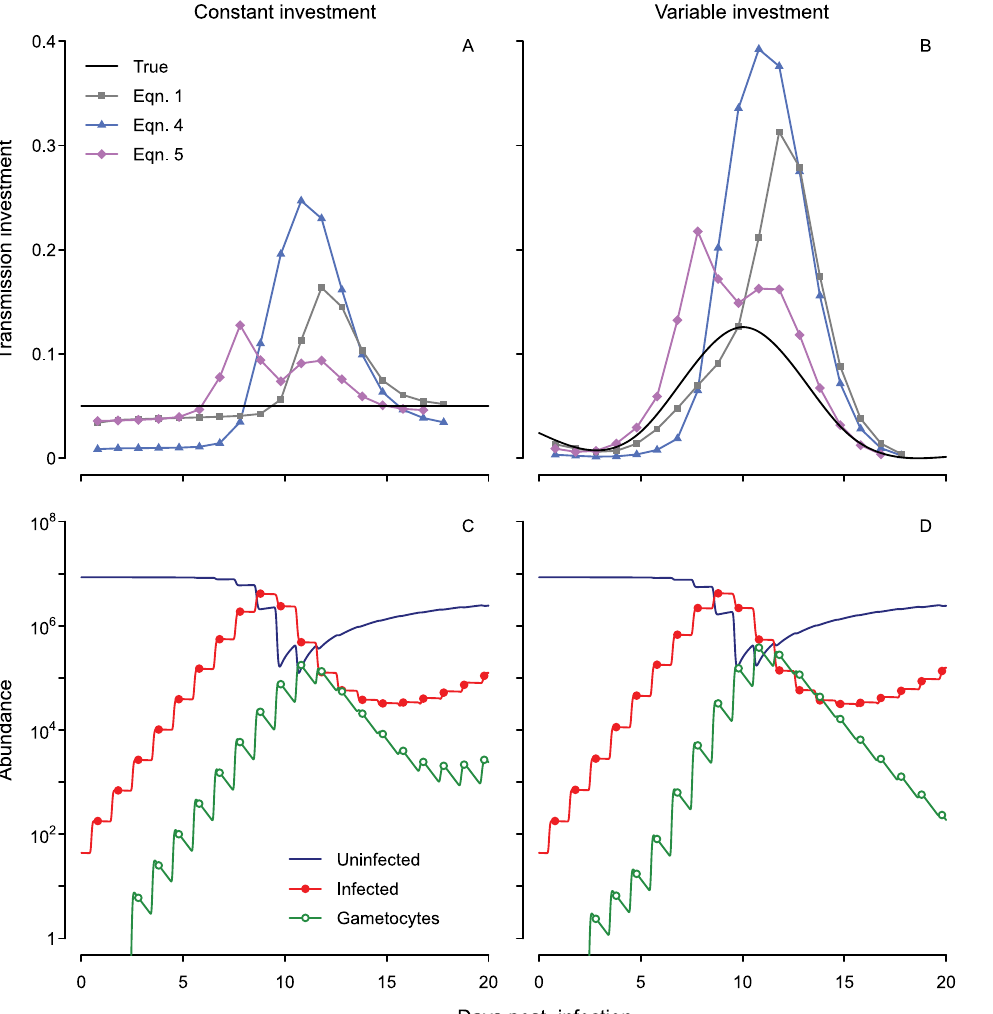
Fig 2. Current methods for inference yield spurious oscillations whether the true transmission investment is constant or variable. Estimates of transmission investment by different methods are shown when the actual level is fixed at 5% (solid black line, A) or variable (B). The corresponding dynamics of uninfected and infected red blood cells (dark blue line and red closed circles, respectively) and mature gametocytes (green open circles) are shown below (C, D). Infected red blood cell abundance includes asexual parasites and developing sexual forms, but not mature gametocytes. We assume a mean gametocyte lifespan of about 20 hours, equivalent to the experimentally-derived half-life of 14 hours for P. chabaudi gametocytes [20].